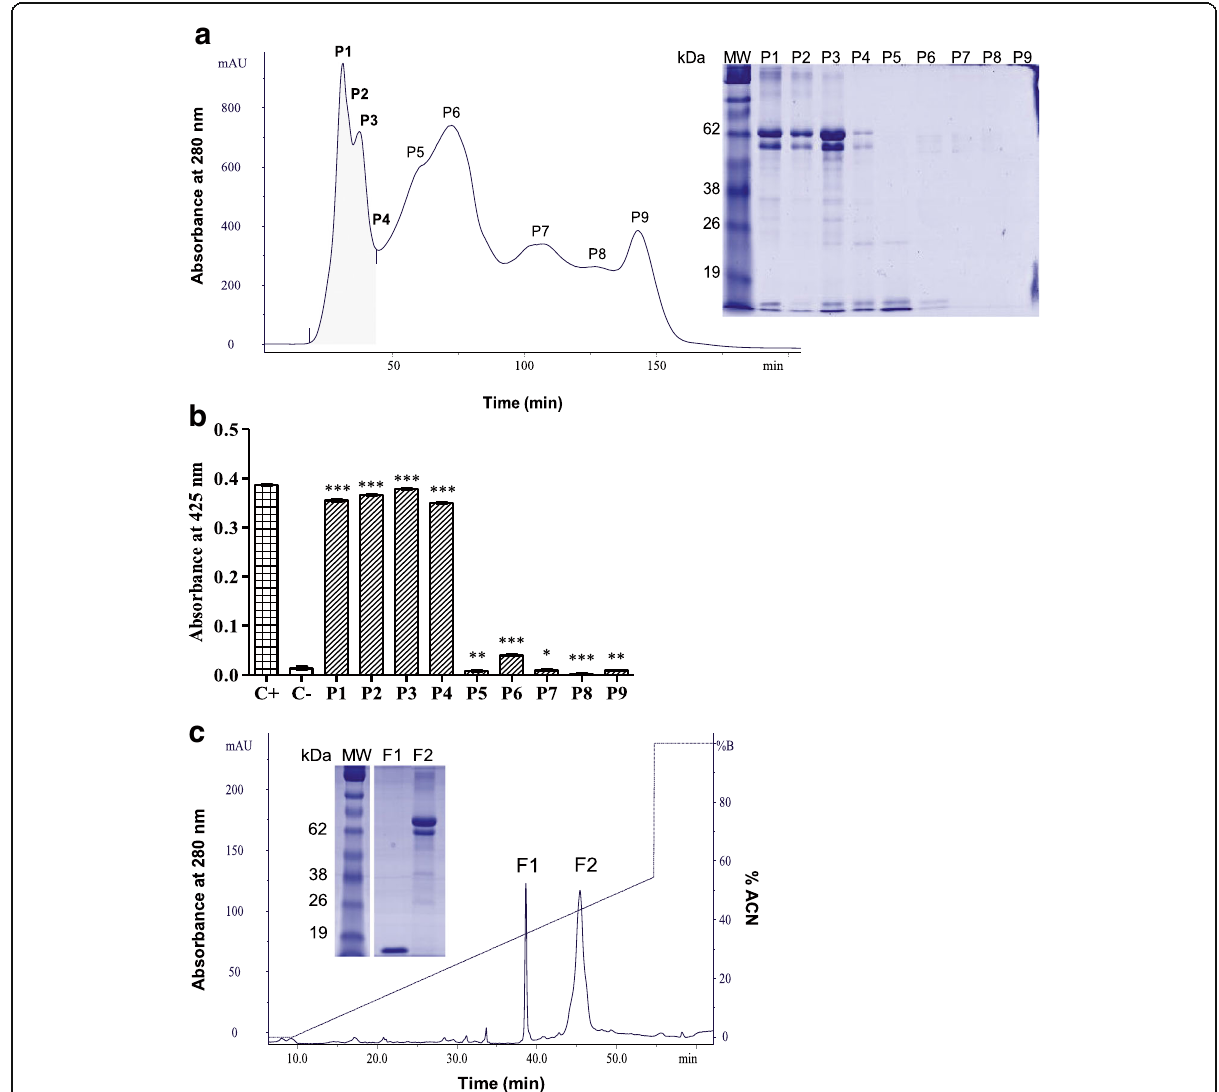
Fig. 1 Purification of PocTX. a P. occidentalis venom (100 mg) was applied to a Sephacryl S200 column, pre-equilibrated with sodium bicarbonate buffer. The eluted fractions were analyzed with 12.5% 1D SDS-PAGE electrophoresis to check the separation profile, where a predominance of relative masses was observed at 65 kDa and 14 kDa. b Next, the fractions (10 μ g) were tested for their phospholipase activity, among which P1, P2, P3 and P4 had activity on the substrate 4N3OBA. c These fractions were mixed and rechromatographed on a reverse phase column, with the elution of two fractions (F1 and F2); upon analysis of the purity of the eluted fractions with 12.5% 1D SDS-PAGE, it was found that one of them showed a single protein band at approximately 14 kDa. The gels were stained with Coomassie Blue G250. The results were expressed as mean ± standard deviation ( n = 3) and submitted to variance analysis followed by the Tukey posttest. *Significant values when compared to the control groups ( p < 0.05). C+: positive control – Bothrops jararacussu venom. C-: negative control – distilled